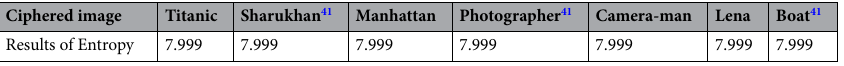
Table 6. Information entropy of some cipher images.